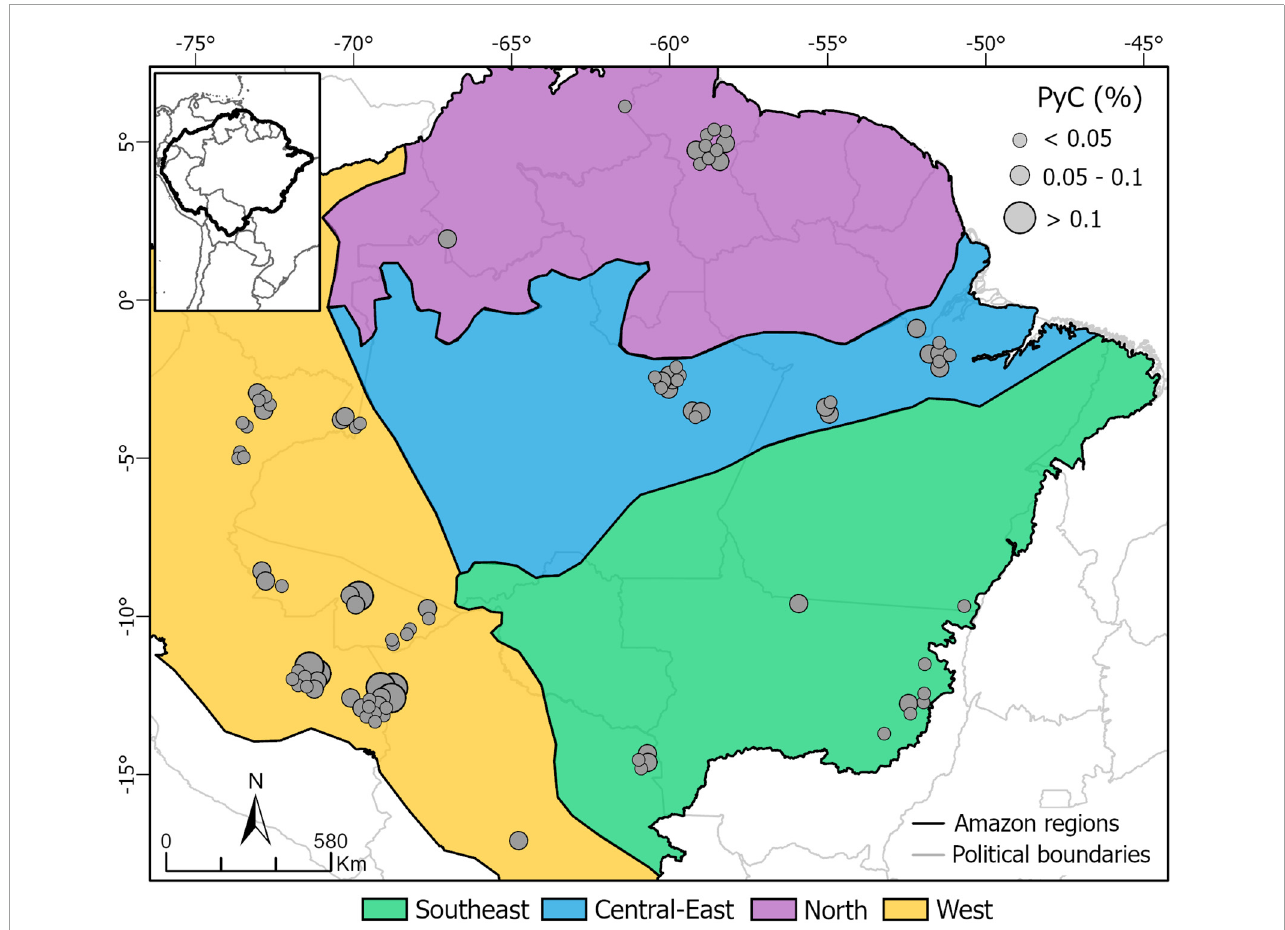
FIGURE2 Spatial distribution of the plots analyzed. Note that locations are approximate and displayed to reduce overlapping points where multiple plots are sampled. The size of the gray dots is proportional to the mean concentration of PyC in the 0–30 cm interval at each site. Amazon regions are defined following Feldpausch et al.